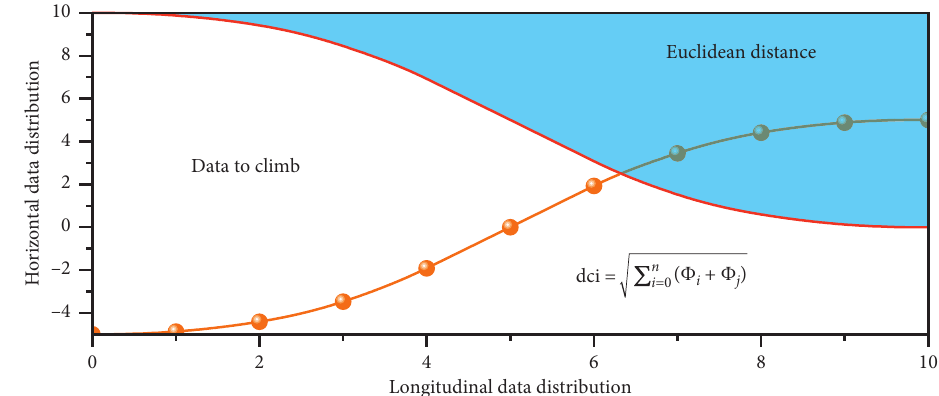
Figure 2: Spectral clustering classification